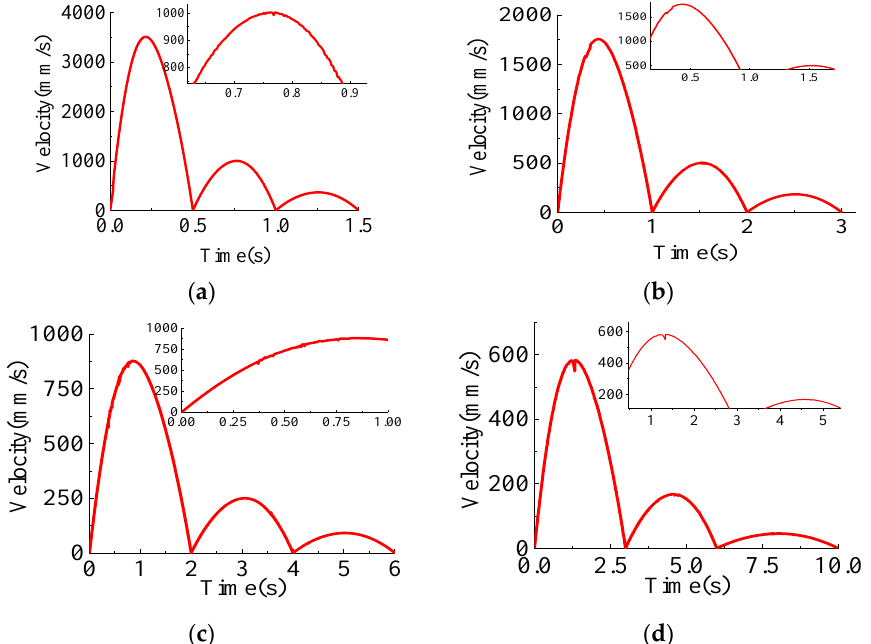
Figure 8. Curve of end velocity change at different rotational speeds: ( a ) Velocity_1; ( b ) Velocity_2; ( c ) Velocity_3; ( d ) Velocity_4.